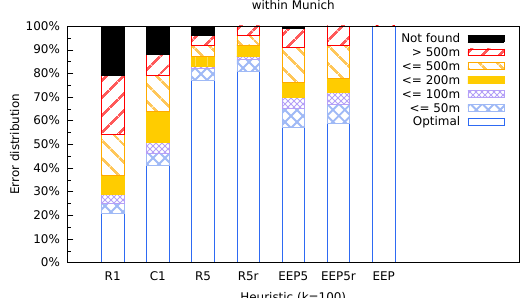
Figure 8: Error distribution withinMunich ( k = 100).